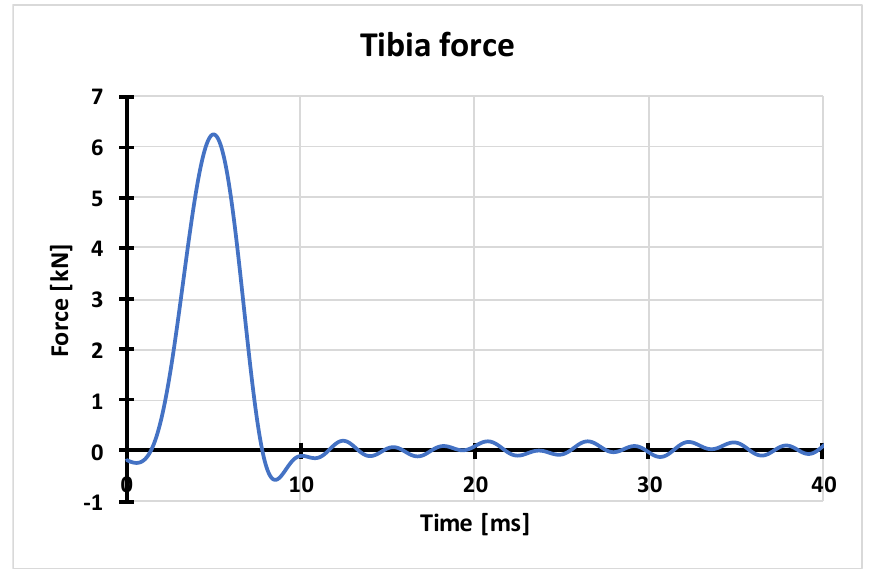
Figure 9. Characteristic of axial force in the dummy’s tibia obtained on the basis of numerical